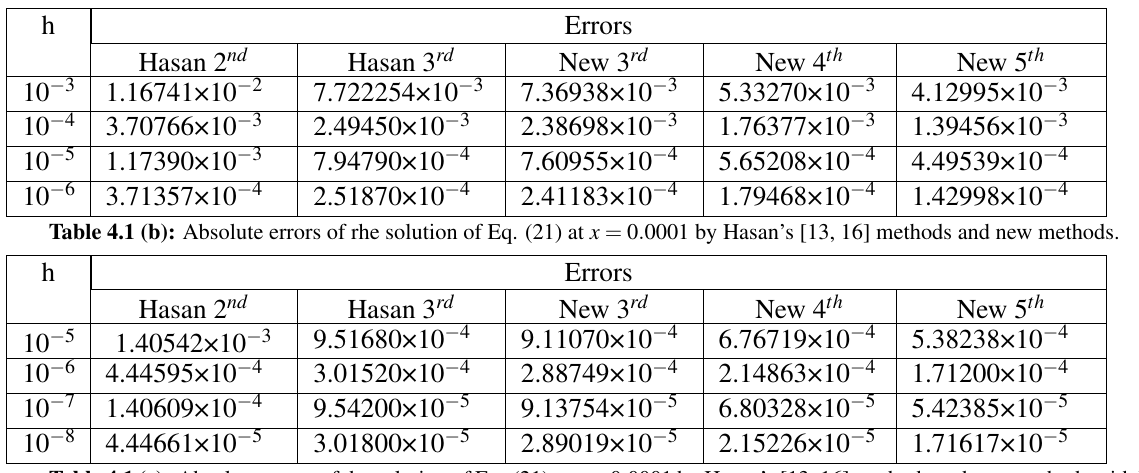
Table 4.1 (a): Absolute errors of rhe solution of Eq. (21) at x = 0 . 01 by Hasan’s [13, 16] methods and new methods.